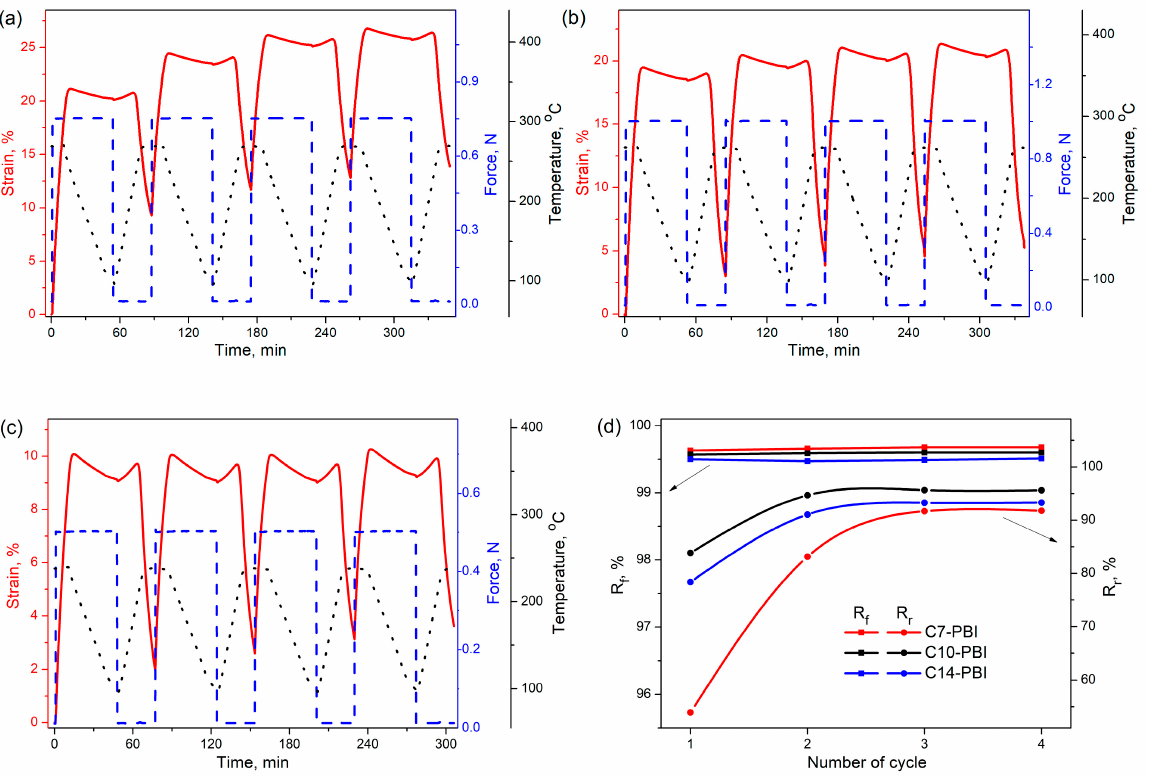
Figure 5. Representative shape-memory cycles of C7-PBI ( a ), C10-PBI ( b ) and C14-PBI ( c ). Cycle vs. shape-memory properties of PBIs ( d